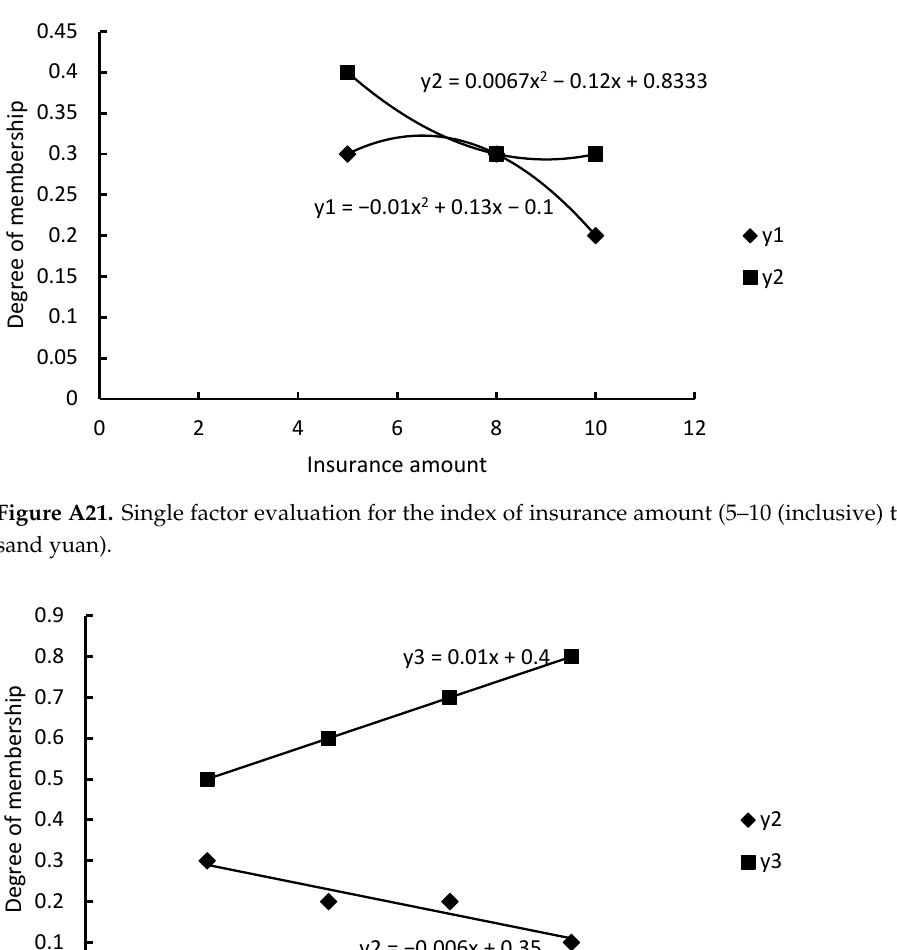
Figure A20. Single factor evaluation for the index of insurance amount (1–5 (inclusive) ten thou- sand yuan).